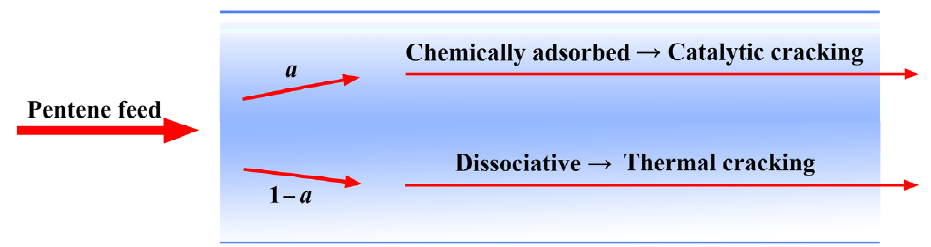
Figure 7. The thermal/catalytic cracking proportion model for pentene cracking over H-ZSM-5.